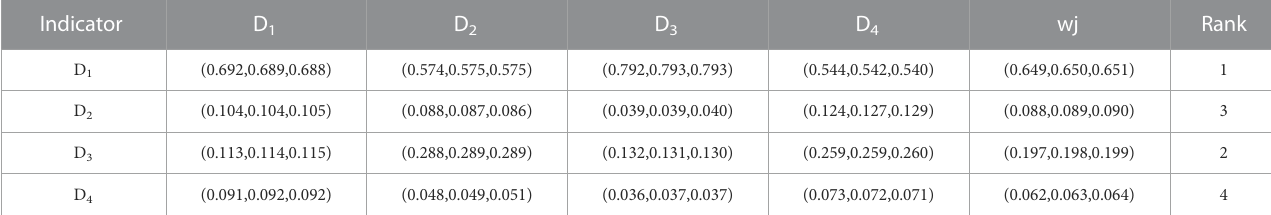
TABLE 13 Standard weight and ranking of factor layer for commissioning and acceptance of power supply department (MCS-AHP). Indicator